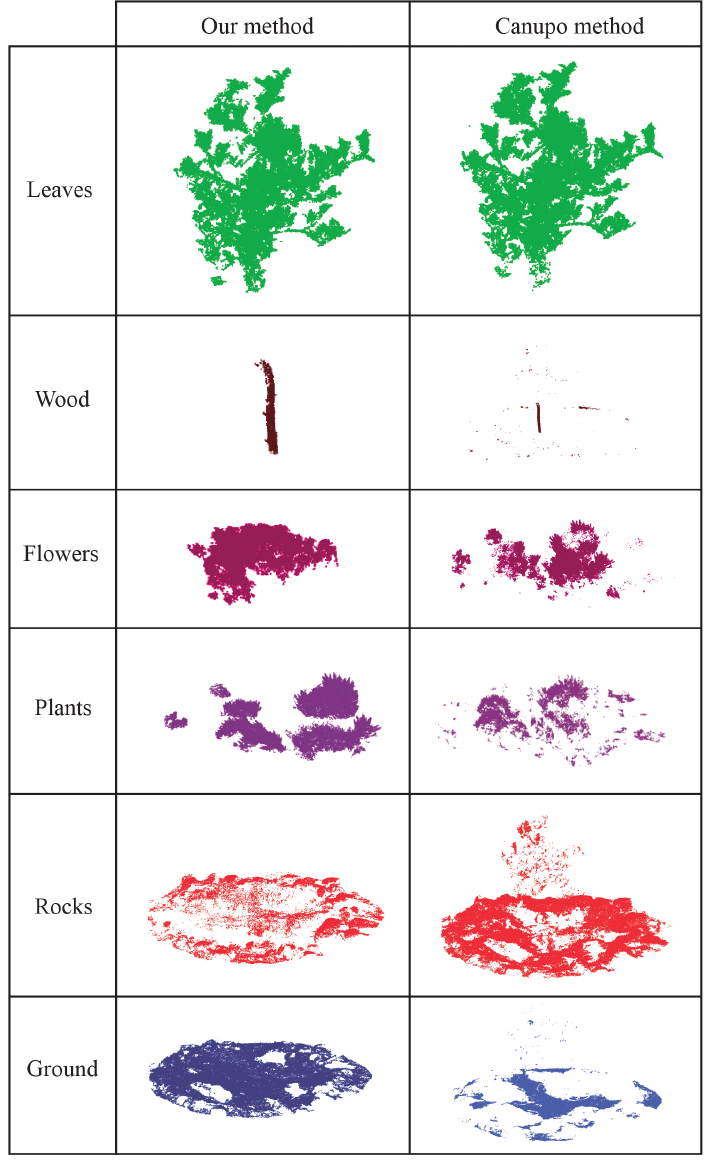
Figure 11. The results of our method and CANUPO